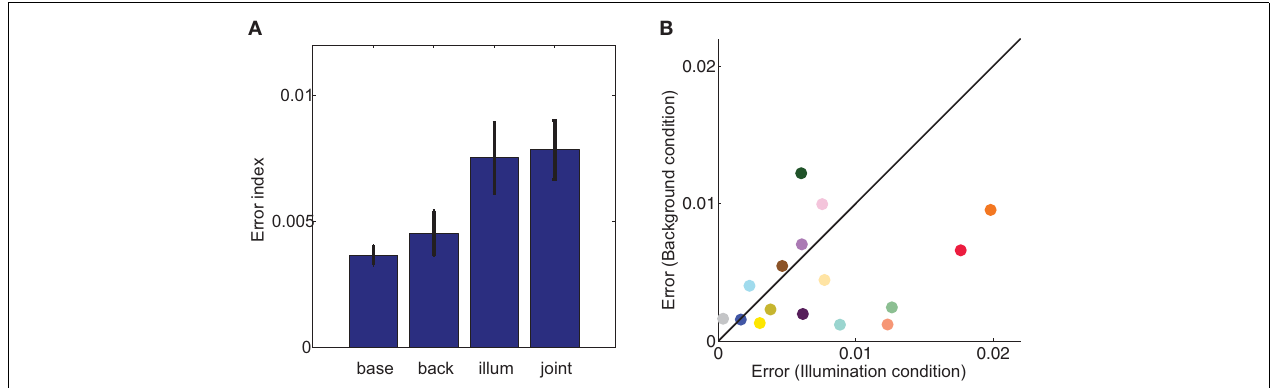
FIGURE 6 | Error index ( eI ) in each of the four labeled experimental conditions (A) and cube-by-cube comparison in the illumination (x-axis) and background (y-axis) conditions (B). In the background, illumination, and joint conditions, the eI is defined by calculating the distance in color space between the chromaticity of the color constancy prediction and the actual average chromaticity of paint chips